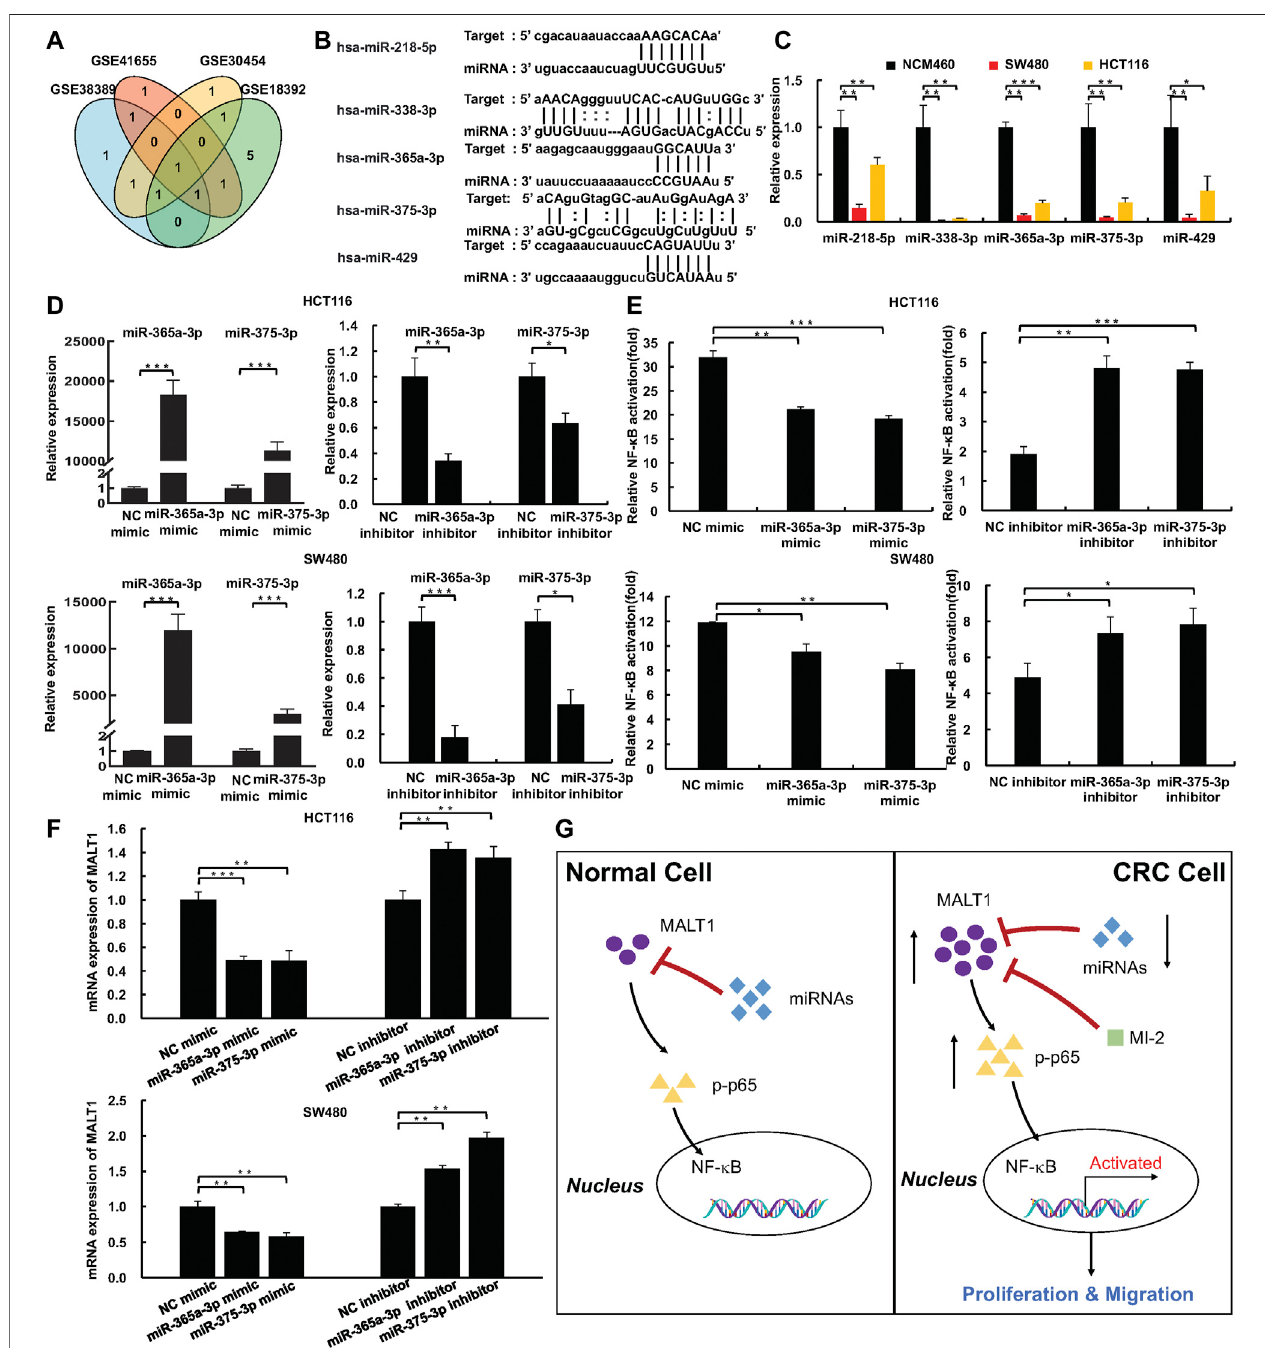
FIGURE6| miR-375 andmiR-365a-3pinhibited NF- κ Bpathwayactivation via targetingMALT1. (A) miR-375,miR-365a-3p,miR-429,miR-218,andmiR-338-3p targeted MALT1 predicted by miRcode and were downregulated in CRC based on GEO database. (B) miR-375, miR-365a-3p, miR-429, miR-218, and miR-338-3p bindingsiteswithin3 ′ UTRofMALT1mRNA. (C) Theexpression ofmiR-375,miR-365a-3p,miR-429,miR-218,andmiR-338-3p inNCMandCRCcelllinesdetectedby qPCR. (D) The expression of miR-375 and miR-365a-3p in CRC cells transfected with miRNA mimic or miRNA inhibitor. (E) Dual-luciferase reporter assays were used to analyze NF- κ B activation in CRC cells. (F) The mRNA level of MALT1 detected by qPCR in CRC cells after transfection as described. (G) Simpli fi ed model of MALT1 promoting CRC development via miR-375/miR-365a-3p/NF- κ B pathway. Each experiment was performed in triplicate, and data are presented as mean ± SD. One-way ANOVA and Dunnett ’ s multiple comparison test were used to analyze the data (* p < 0.05, ** p < 0.01, *** p < 0.001).